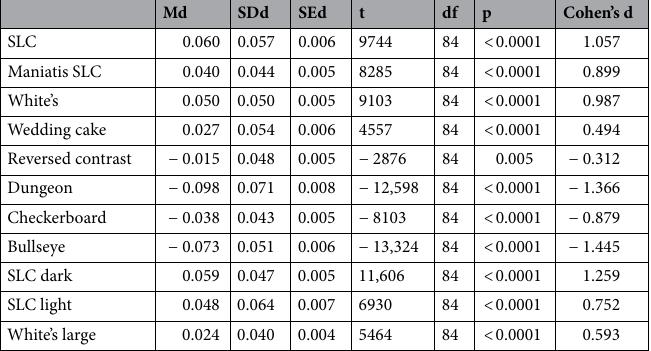
Table 1. Paired samples t-test results, representing the difference between left and right target matches.